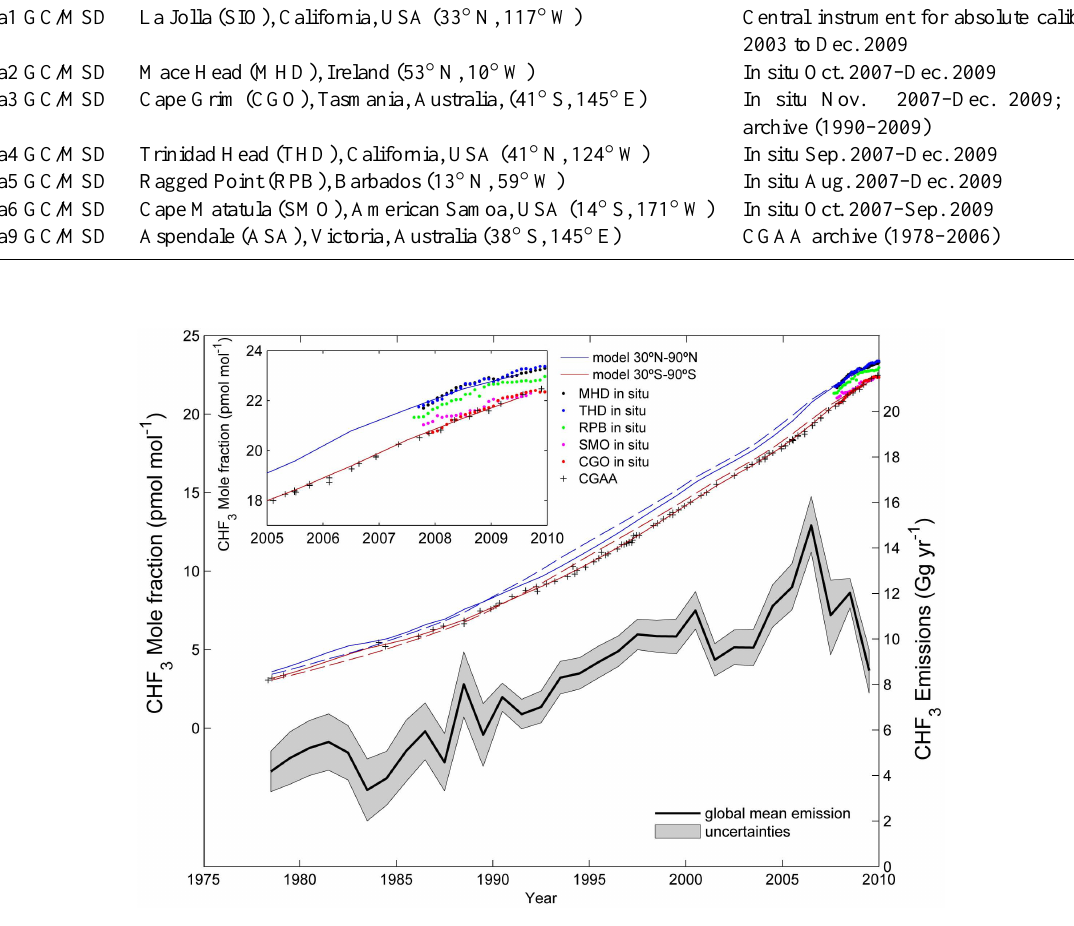
Fig. 1. Atmospheric HFC-23 (CHF 3 ) mole fractions (left axis and inset) based on the monthly means of AGAGE “Medusa” GC/MSD in situ measurements at 5 remote sites and from Cape Grim air archive (CGAA) samples. Model optimized annual mean mole fractions (solid lines) from inversion using the 2-D 12-box model are shown for the high latitude northern and southern semi-hemisphere boxes. Model annual mean a priori mole fractions are also shown (dashed lines) to illustrate that the a priori emission estimate produces mole fraction growth rates that generally agree with the observations. The HFC-23 global emission estimate from the inversion is shown along with uncertainties (right axis). The atmospheric trend shows deceleration in growth since 2006 that is reflected in a maximum emission of 15.0 (+1.3/-1.2) Gg HFC-23 in 2006, followed by decreasing emissions over the subsequent three years to a low of 8.6 (+0.9/-1.0) Gg, which is the lowest emission of the past 15